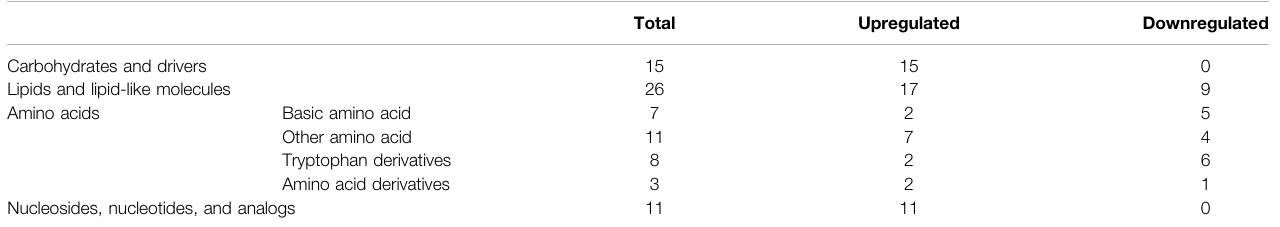
TABLE 1 | Distribution and changes of differential metabolites in DKD serum. Total Upregulated Downregulated Carbohydrates and drivers 15 15 0 Lipids and lipid-like